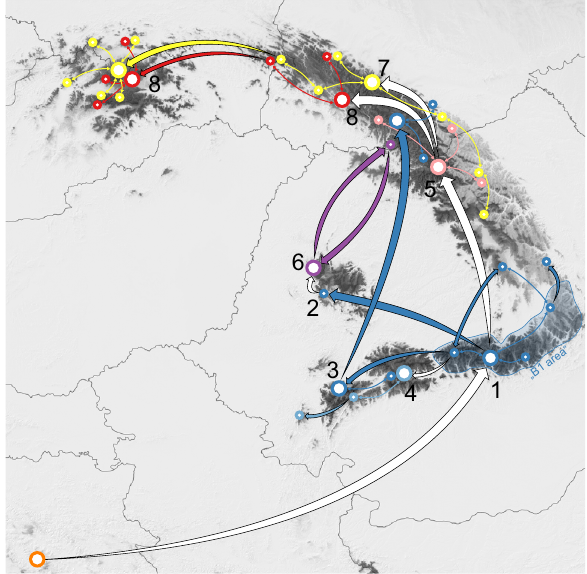
Figure 6. Hypothetical phylogeographic history and migration routes as inferred from haplotype network reconstruction, ecological niche modeling, and RASP analysis (Bayesian binary Markov Chain Monte Carlo). Dispersal and/or vicariance events are numbered and discussed in the text. Thick arrows indicate the emergence of a new haplotype (white arrows) or long-distance dispersal of the haplotypes belonging to the same cluster (arrows in color). Smaller bidirectional arrows indicate connections between populations where the same haplotypes were found. The colors correspond to those assigned to the haplotypes by the clustering algorithm (Fig. 4). The underlying map is generated from ecological niche modeling for the current period, and it is the first axis of the principal component analysis of the five algorithms (as in Fig. 5j) with darker colors indicating higher suitability. For ease of interpretation, political borders between countries are included. The maps are drawn using R ver. 3.6.2 76 and QGIS ver. 3.8 77